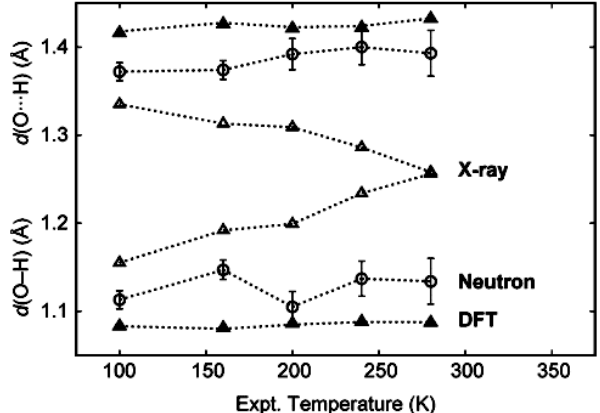
Figure 3. Effects of temperature on the O–H and O···H distances of dibenzoylmethane. X-ray (open triangles) and neutron diffraction (open circles) data [61] are plotted along with DFT optimized O–H and O···H bond lengths (filled triangles) [24]. Error bars are plotted for the neutron-derived data, while those for X-ray data have been left out for clarity, and dotted lines serve only as guides to the eye [56]. Reprinted, with permission, from [24]. Copyright 2012, by The American Chemical Society.